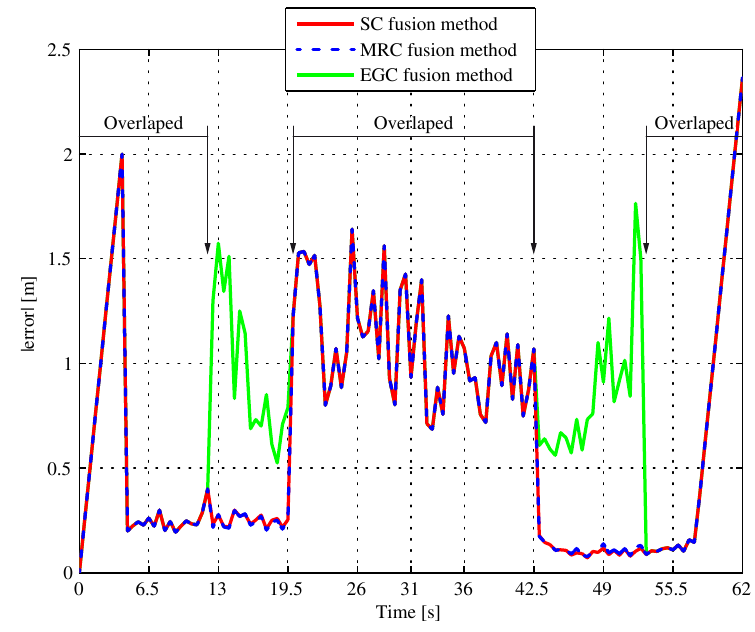
Figure 13. Instant error of the fusion positions when using the SC, MRC and EGC